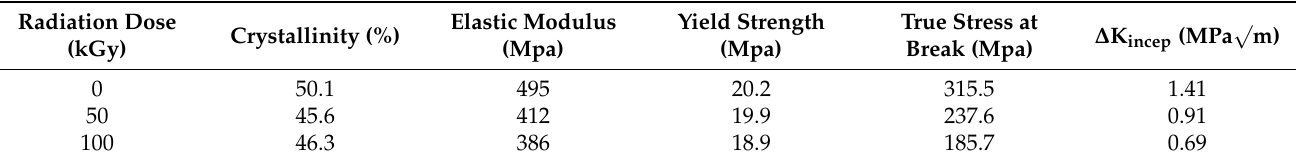
Table 2. Mechanical properties and fatigue strength of ultra-high-molecular-weight polyethylene [36]. Reproduced with permission from Baker D.A. et al, Journal of Biomedical Materials Research Part A; published by John Wiley and Sons, 2003.